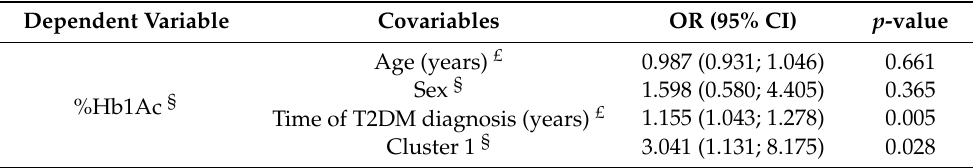
Table 3. Binary logistic regression model of glycated hemoglobin percentage (%HbA1c) and clusters formed from energy-adjusted mineral intake by individuals with type 2 diabetes mellitus